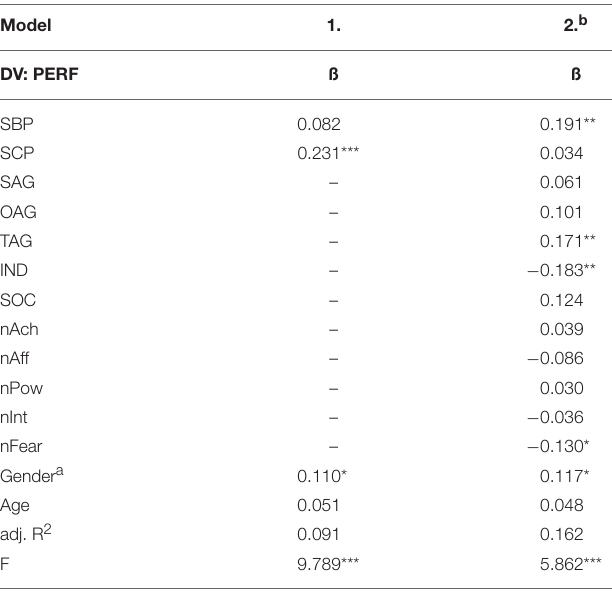
TABLE 4 | Relation of self-based pride and social comparison-based pride with performance (Model 1) and the relation of self-based pride and social comparison-based pride with performance under control of all antecedent variables (Model